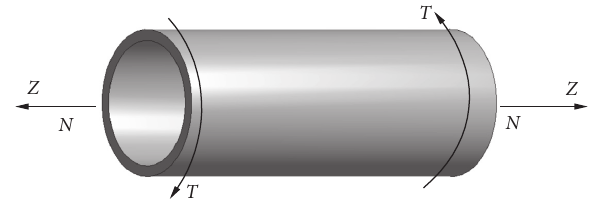
Figure 1: Thin-walled circular tube analysis model (From reference